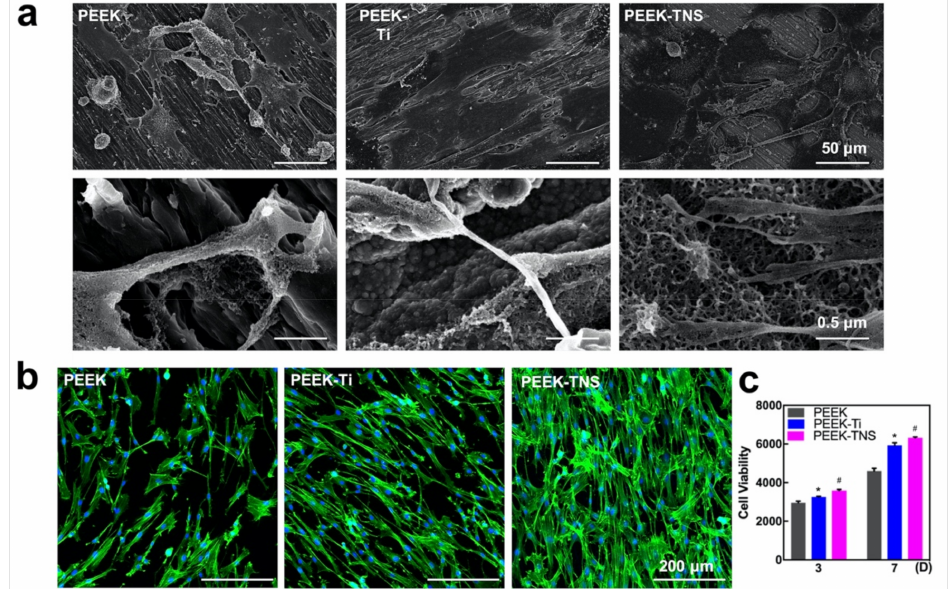
Figure 5. Cell growth, morphology, and proliferation of rBMMSCs on PEEK, PEEK-Ti, and PEEK- TNS. ( a ) SEM images illustrating the cell growth and morphology of rBMMSCs. ( b ) Cytoskeletons of rBMMSCs stained with phalloidin (green) and nuclei stained with DAPI (blue) for 24-h culturing. ( c ) Cell proliferation for 3 and 7 days. (* represents p < 0.05 when PEEK-Ti is compared with PEEK; # represents p < 0.05 when PEEK-TNS is compared with